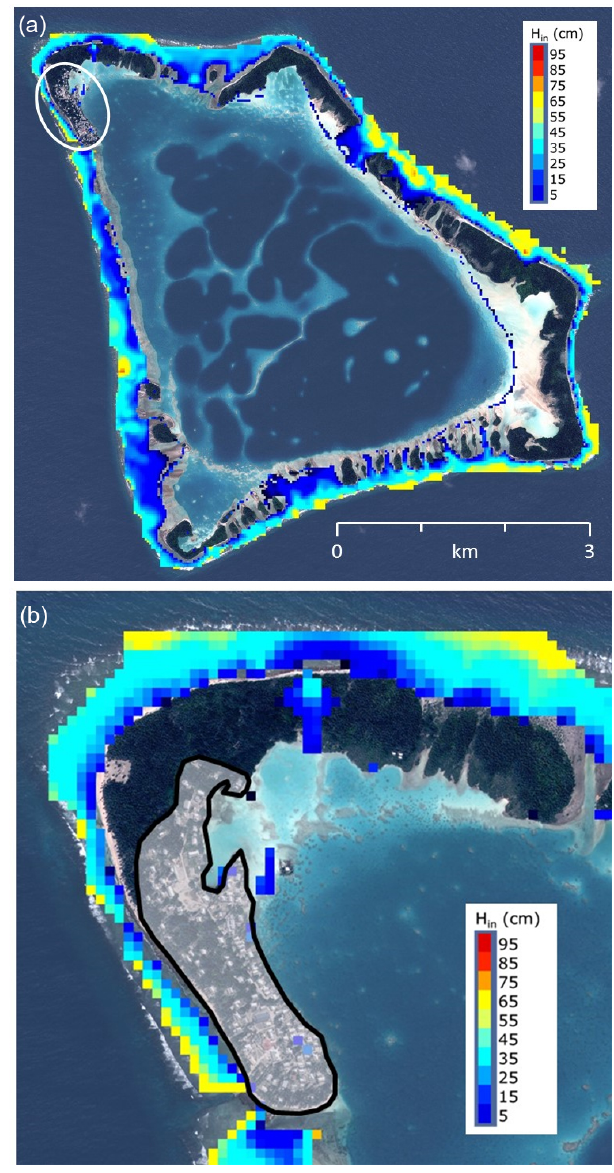
Figure 9. (a) Modelled tsunami-flood inundation depths (in cen- timetres above land, H in ) on the atoll of Atafu from all regional- earthquake sources. The location of the village is outlined by the white ellipse. (b) Zoomed in image of the modelled tsunami- flood inundation depths for the village on Atafu from all regional- earthquake sources. The land area of the village is indicated by the semi-transparent grey